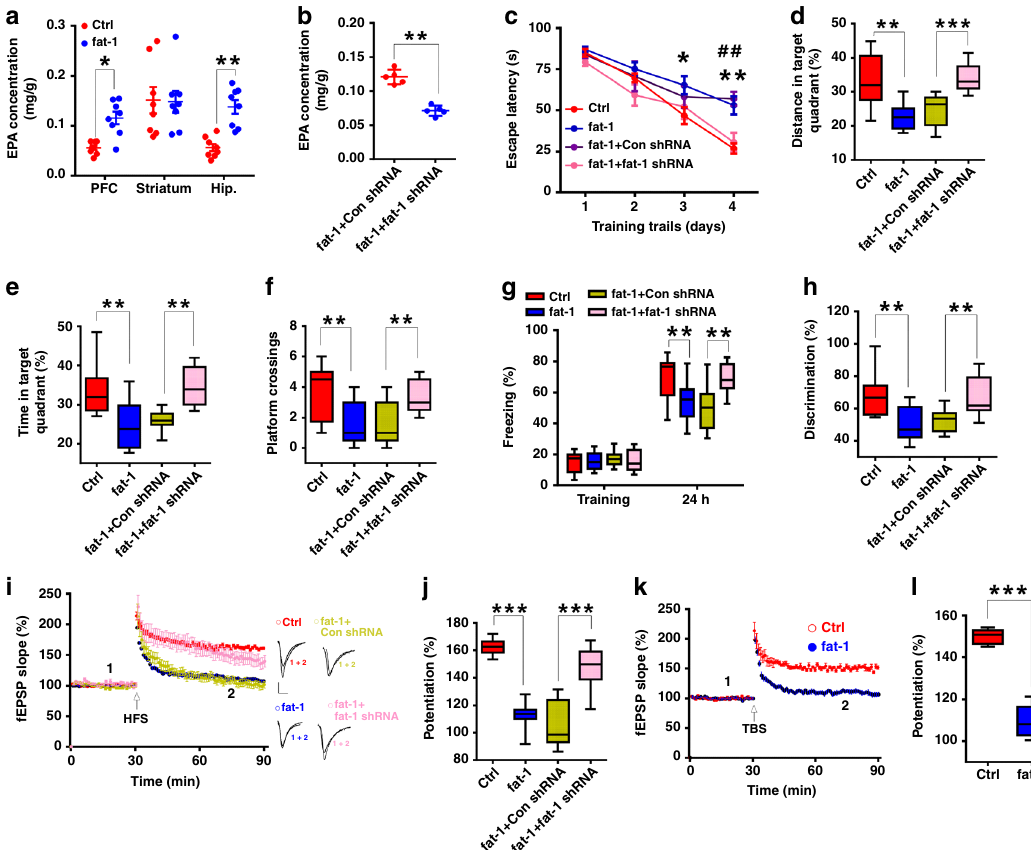
Fig. 2 Elevated EPA in the hippocampus led to de fi cits in learning and memory and LTP in fat-1 mice. a Fat-1 mice exhibited increased EPA level in the PFC and hippocampus ( n = 8, two-tailed Student ’ s t -test, PFC: P = 0.036; striatum: P = 0.102; Hip.: P = 0.007). b Effect of hippocampal knockdown of the fat-1 gene on the EPA level in fat-1 mice ( n = 4 – 5, two-tailed Student ’ s t -test, P = 0.006). c – f Performance in the MWM in fat-1 mice with or without intrahippocampal injection of shRNA ( n = 9 – 10 mice/group; c : repeated measures two-way ANOVA, F (3, 128) = 45.215, P < 0.0001; d : one-way ANOVA, F (3, 33) = 43.381, P = 0.013; e : one-way ANOVA, F (3, 33) = 3.168, P = 0.012; f : one-way ANOVA, F (3, 33) = 55.685, P = 0.010). In c , asterisk or hash indicate differences between Ctrl and fat-1 groups, fat-1 + Con shRNA and fat-1 + fat-1 shRNA groups, respectively. g , h Freezing time in the contextual fear conditioning test ( n = 9 – 10 mice/group; one-way ANOVA, F (3, 33) = 47.032, P = 0.002) and discrimination ratio in the NOR test ( n = 9 – 10 mice/group; one-way ANOVA, F (3, 33) = 53.126, P = 0.001) after hippocampal knockdown of the fat-1 gene. i – l Suppressed HFS-LTP ( i , j : Ctrl n = 10 – 26 slices/group; one-way ANOVA, F (3, 59) = 59.684, P < 0.0001) and TBS-LTP ( k , l : n = 5 – 6 slices/group; two-tailed Student ’ s t -test, P < 0.0001) in hippocampal slices of fat-1 mice were rescued by fat-1 shRNA treatment. Data show mean ± s.e.m. Scale bars: 0.5 mV, 5 ms. * P < 0.05, ** P < 0.01, *** P <